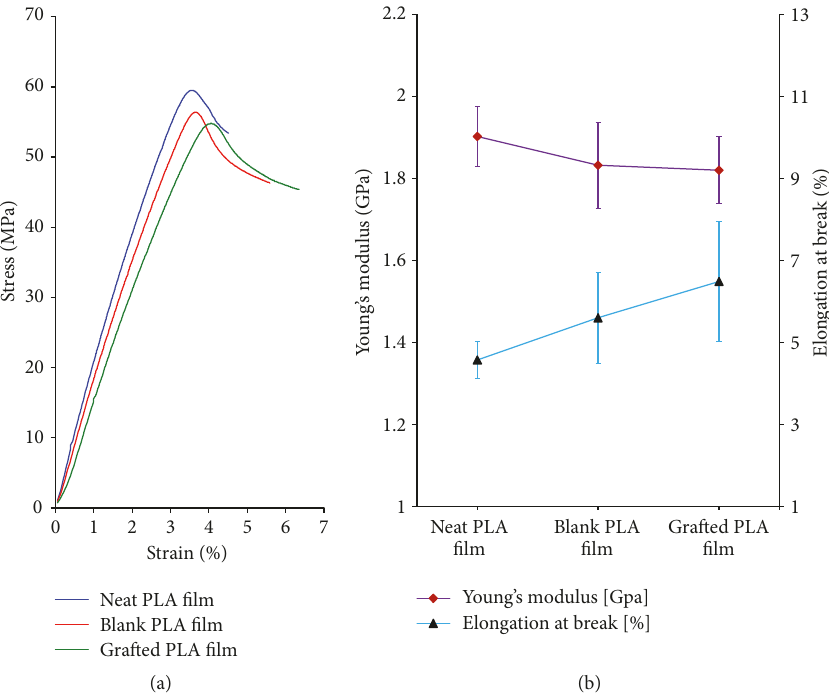
Figure 10: Stress-strain curves (a) and Young’s modulus and elongation at break values (b) of neat, blank, and grafted PLA films.